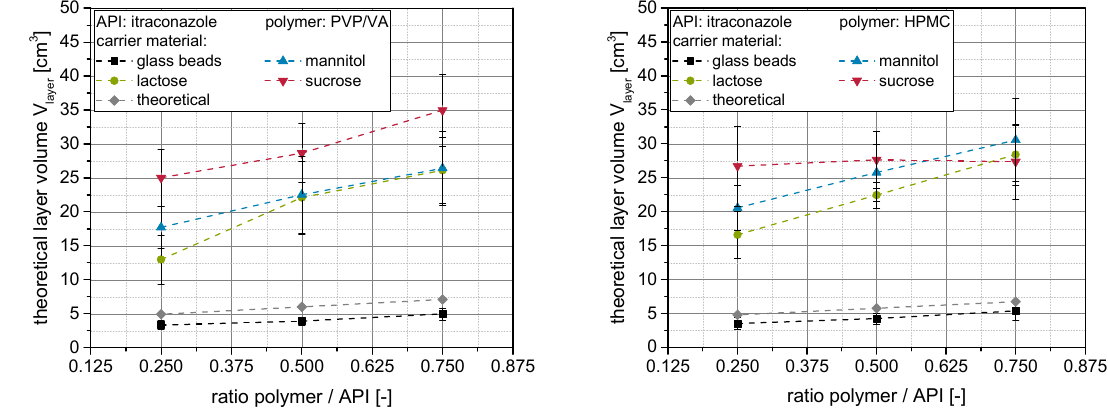
Figure 7. Microscopically derived nanoparticle layer volumes V layer derived from specific surface areas of carrier starting materials and layer thickness determination by confocal Raman spectroscopy ( n = 10) for granules produced with different carrier materials (glass beads, lactose, mannitol or sucrose) and an itraconazole nanosuspension stabilized with different amounts of PVP/VA ( left ) or HPMC ( right ).